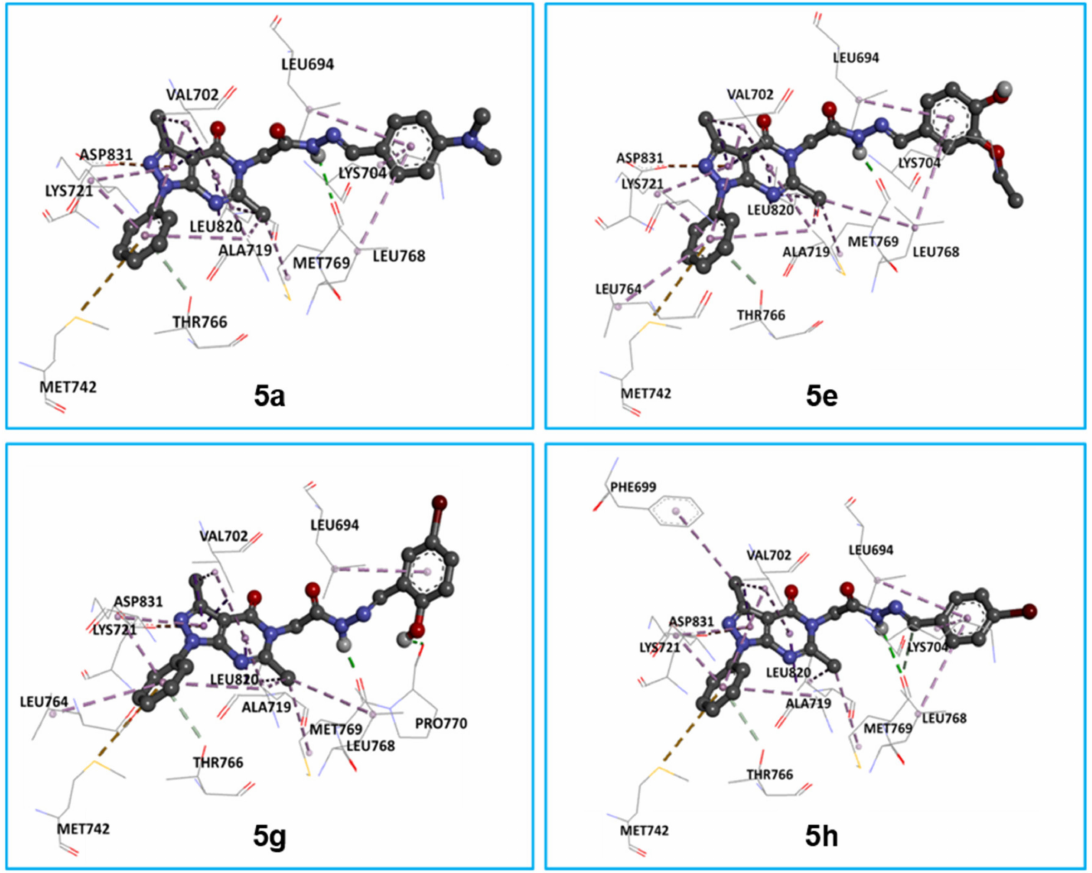
Figure 5. Binding modes of conjugates 5a, 5e, 5g , and 5h in the erlotinib binding site of the epidermal growth factor receptor (EGFR) (PDB: 1M17). Table 3. ∆ T m of analyzed sequences in the presence of 5a , 5e , 5g , and 5h . 1 ∆ T m values are the differences in the melting temperatures of DNA in the presence and absence of ligands. The error